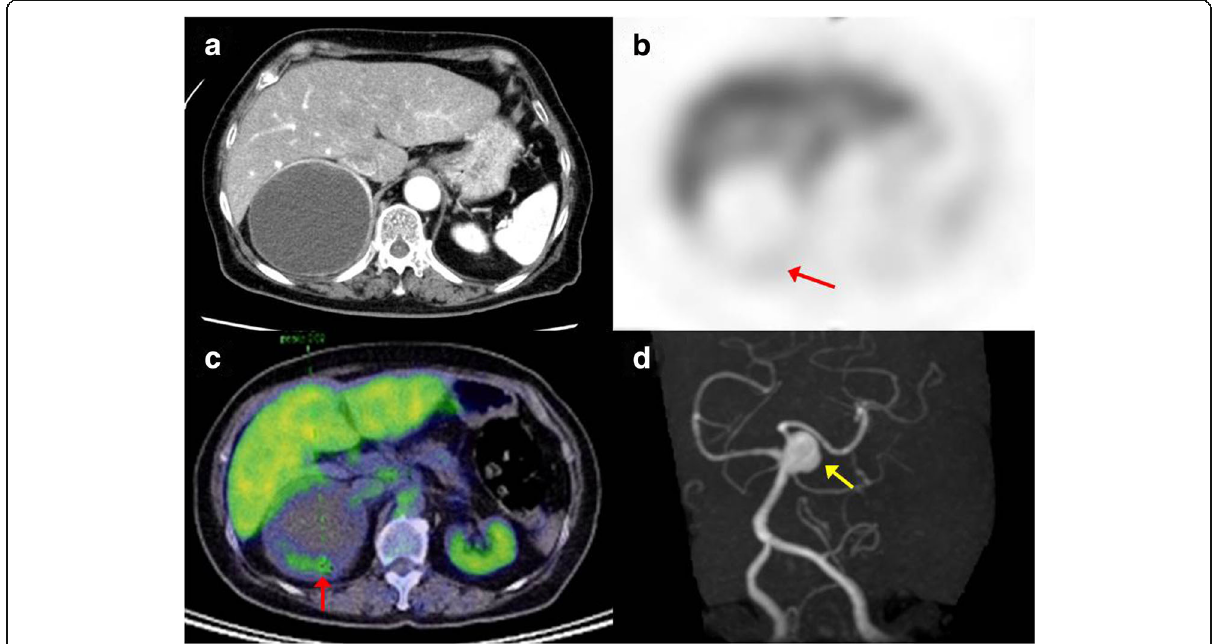
Fig. 1 Preoperative findings. a Enhanced computed tomography showed a cystic retroperitoneal tumor with a maximum diameter of 88 mm within the right adrenal gland. It had a walled nodule; a contrast effect was observed in the early phase along the cyst wall, including the nodule. b 123 I-meta-iodobenzylguanidine scintigraphy and c positron emission tomography with 2-deoxy-2-[fluorine-18] fluoro-D-glucose/computed tomography examination, showing the abnormal accumulation of the markers along the cyst wall (red arrow). d Magnetic resonance angiography showing an 8-mm-diameter cerebral aneurysm at the origin of the left anterior cerebral artery (yellow arrow)